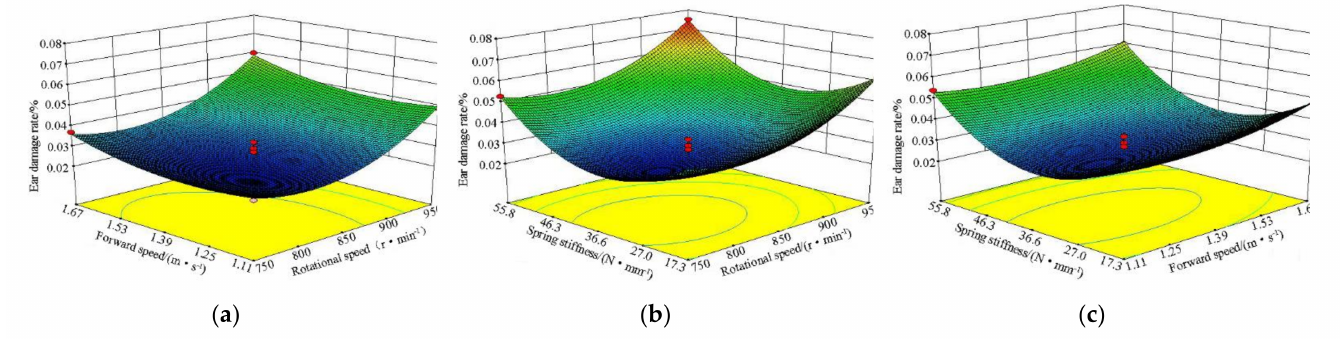
Figure 11. Effects of various factors on ear damage rate: ( a ) y ( X 1 , X 2 ,0); ( b ) y ( X 1 ,0, X 3 ); ( c ) (0, X 2 , X 3